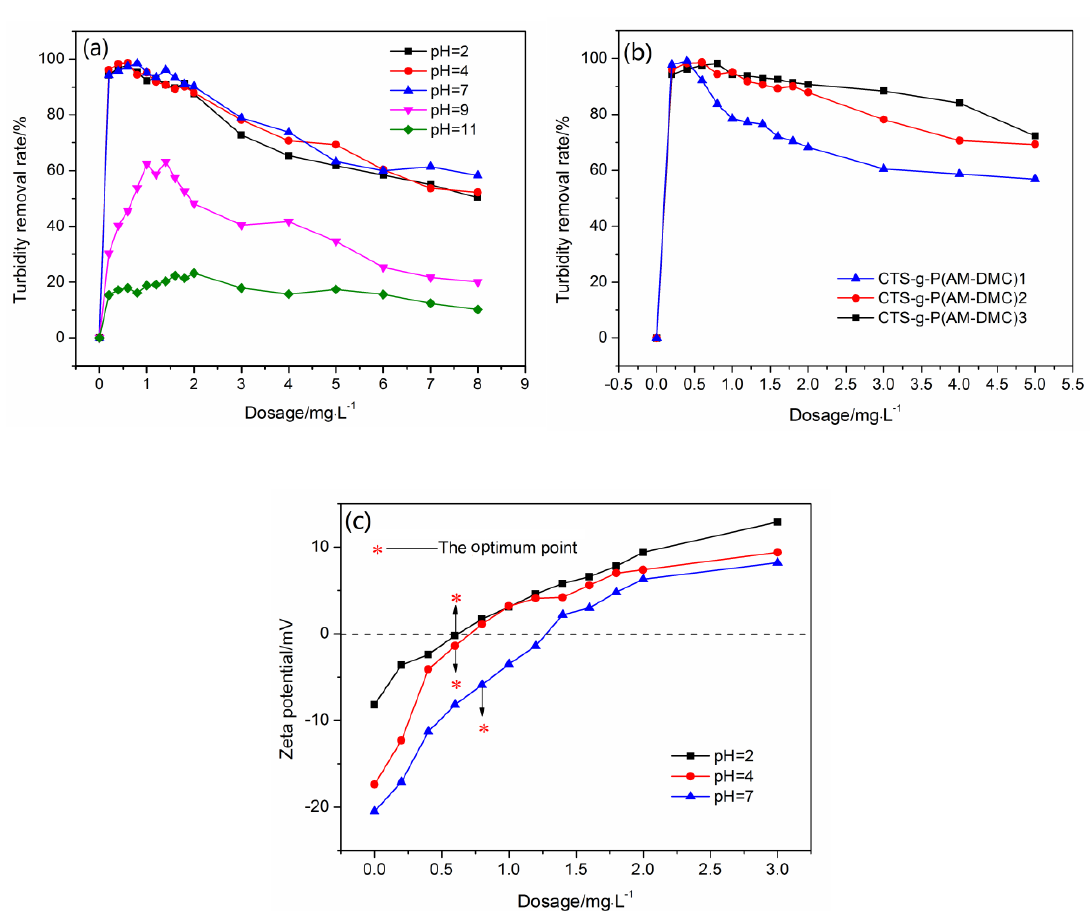
Figure 7. Flocculation performance of CTS- g -P(AM-DMC) in the kaolin suspension: ( a ) Effect of dosage and pH; ( b ) Effect of graft ratio; ( c ) Zeta potential of the supernatant as a function of flocculants